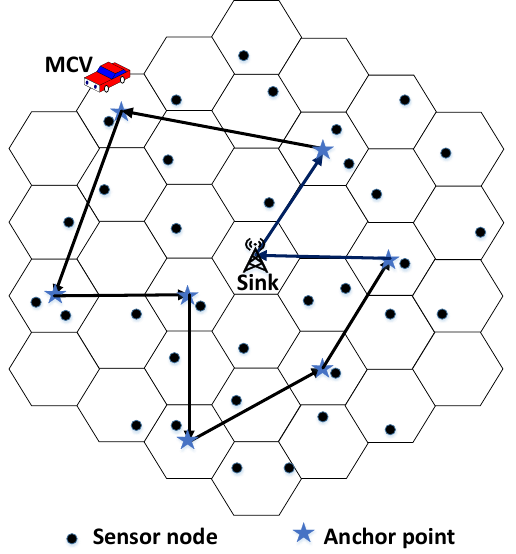
Figure 1. Example of a sensor network with a mobile charger vehicle (MCV).